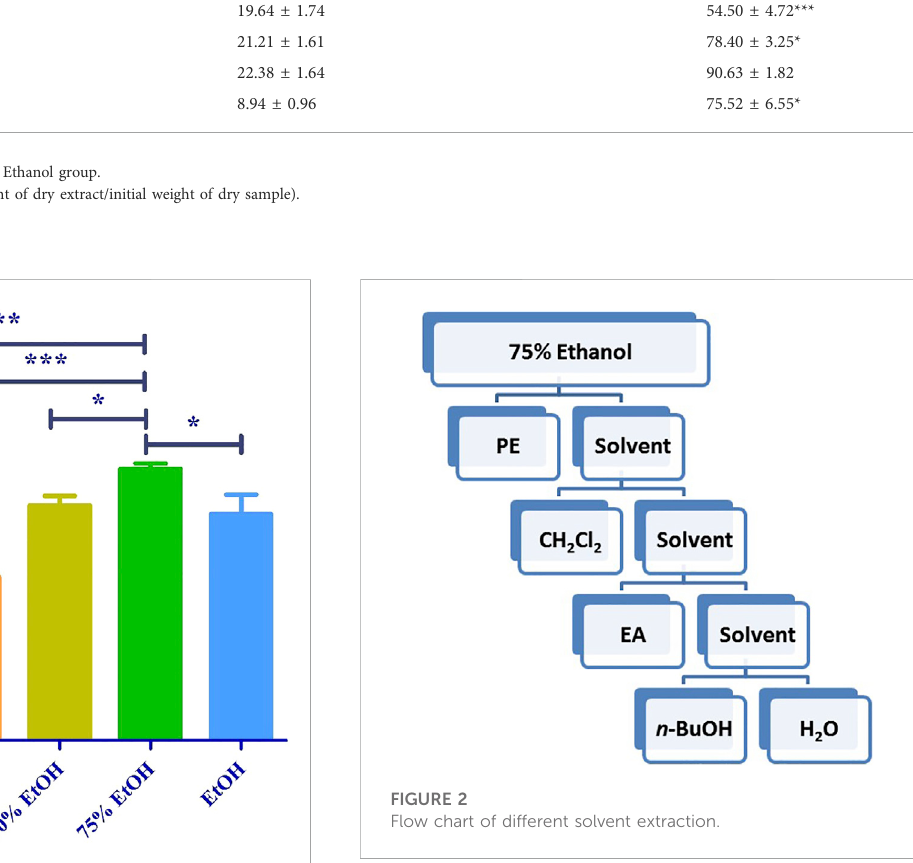
Relaxtion of Lotus leaf with different extraction solvents. The data are expressed as the means ± SD of 3 rats ( n = 3). (* mean p < 0.05; *** mean p < 0.001 vs. 75% Ethanol